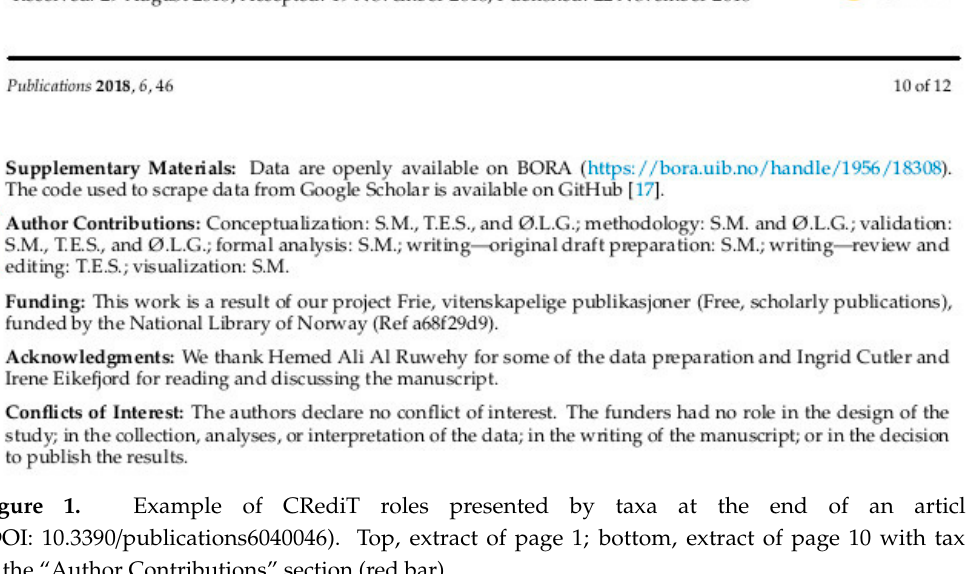
Figure 1. Example of CRediT roles presented by taxa at the end of an article (DOI: 10.3390 / publications6040046). Top, extract of page 1; bottom, extract of page 10 with taxa in the “Author Contributions” section (red bar).